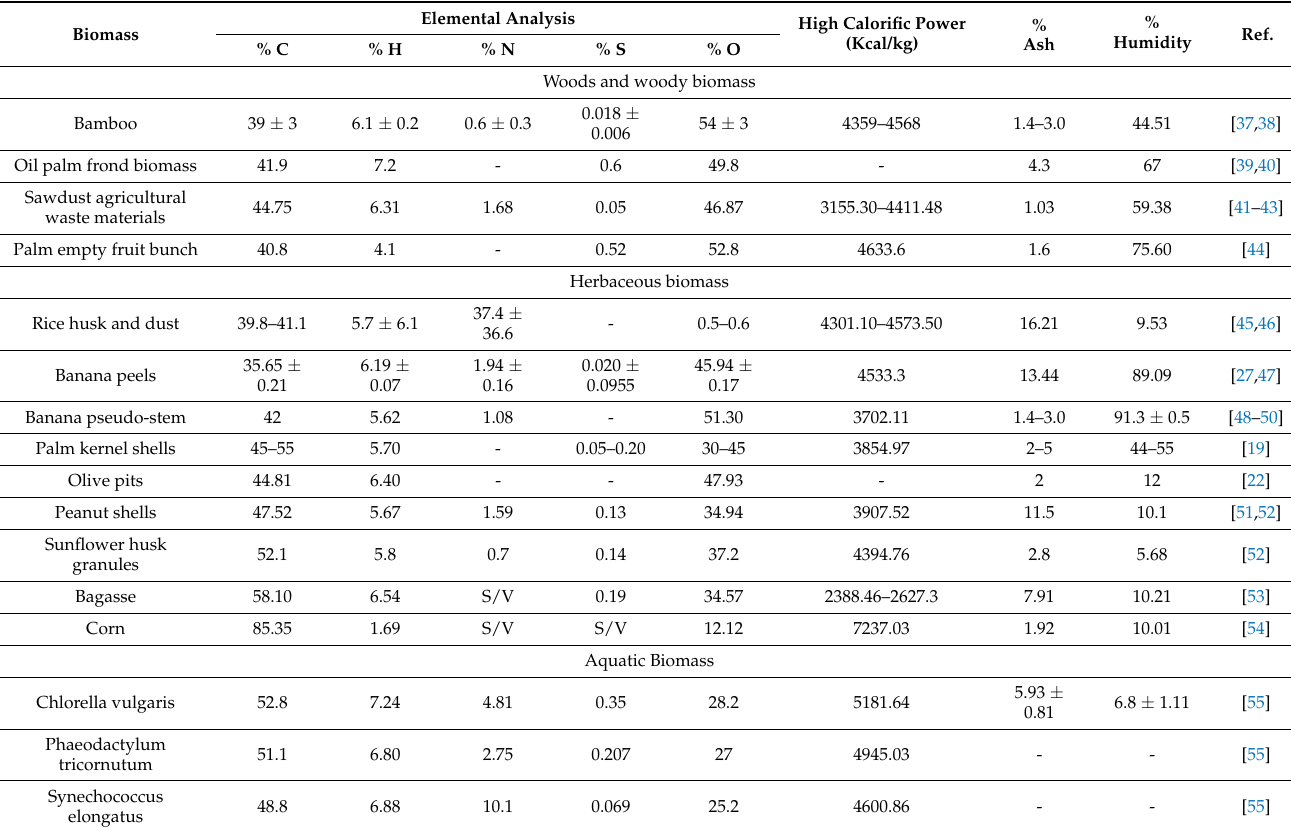
Table 1. Lignocellulosic biomass characteristics for hydrogen